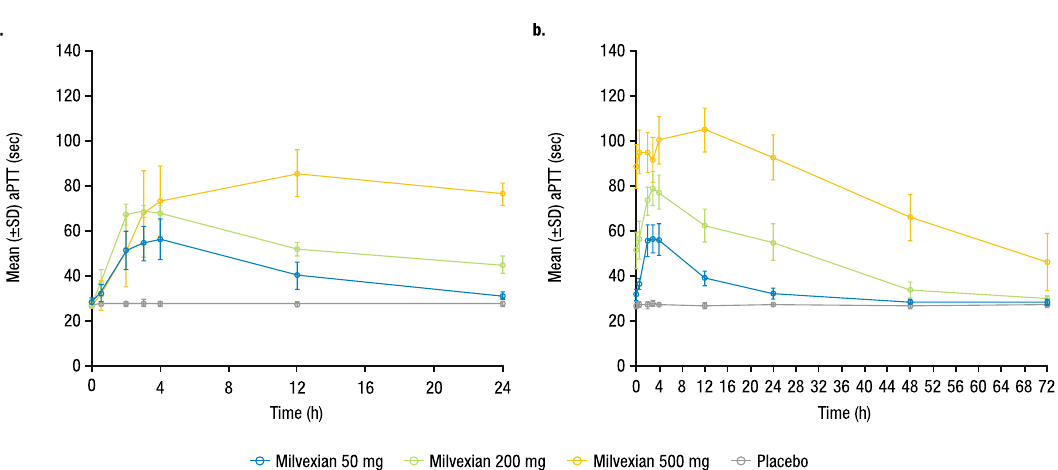
Figure 2. Mean (± SD) aPTT profile over time on ( a ) Day 1 and ( b ) Day 14. SD, standard deviation; aPTT, activated partial thromboplastin time. Milvexian 50 mg and 200 mg were administered under fasted conditions. Milvexian 500 mg was administered under fed